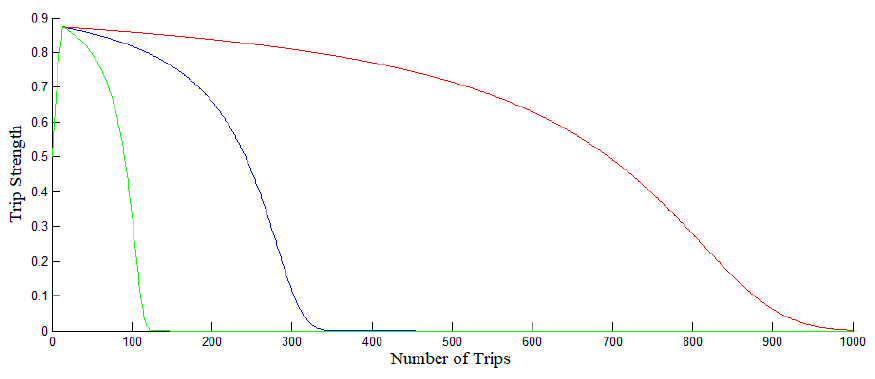
Figure 23. Trip strength dynamics.